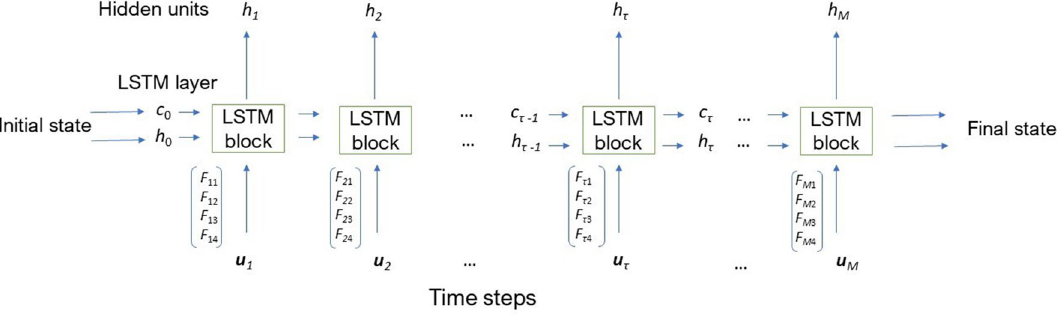
Figure 2. TF–TS LSTM layer Fuzzy recurrence image entropy.